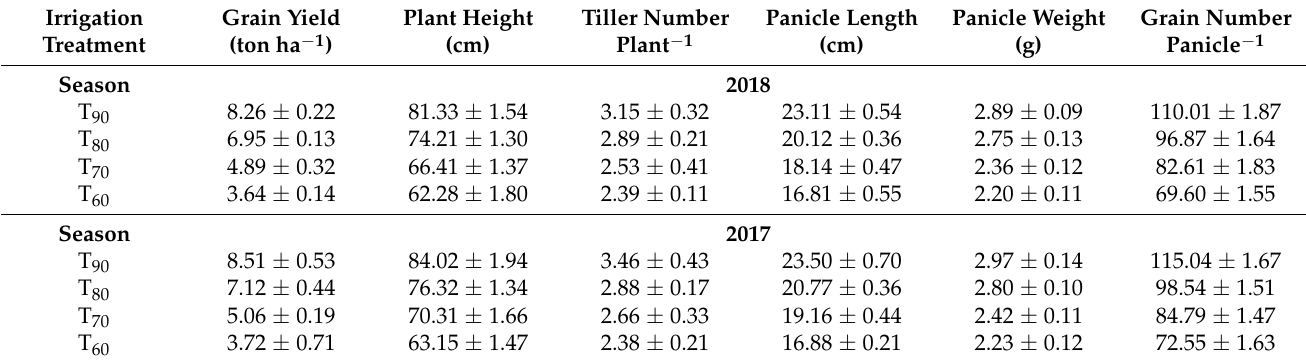
Table 9. Effect of deficit irrigation treatments on growth and yield of rice crop.